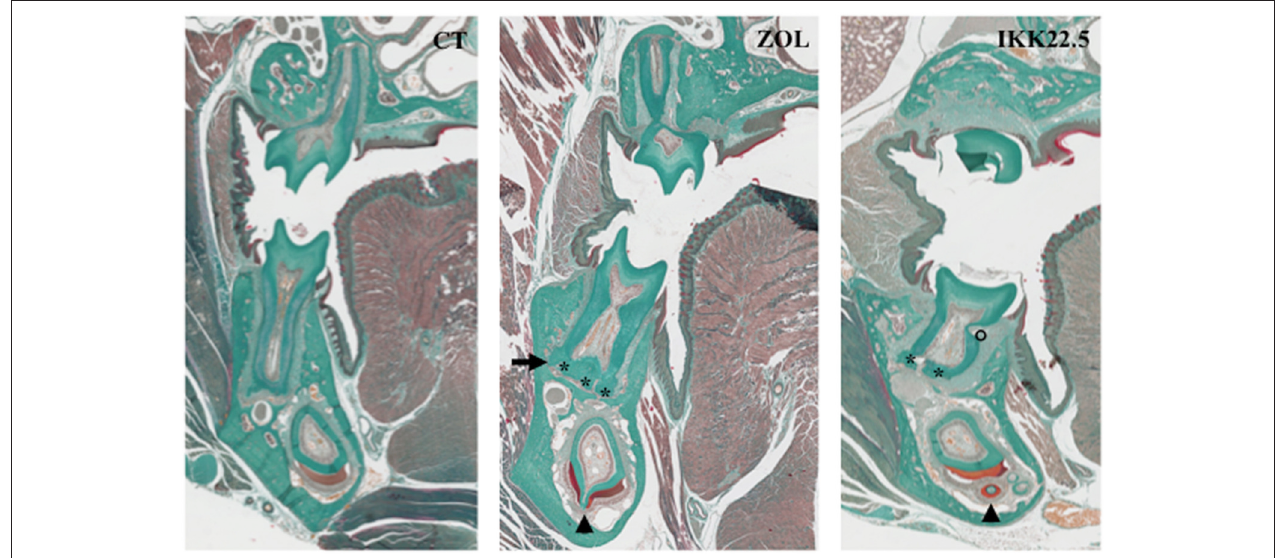
FIGURE 5 | Dental and periodontal consequences of four injections of ZOL or IKK22.5 in newborn mice, 3 months after the last injection. Head frontal sections in the plane of the first molars show the presence of ankylosis (arrow), hyper-cementosis (stars), enamel organ disorganization (arrow-heads), and root resorption (circle) in treated